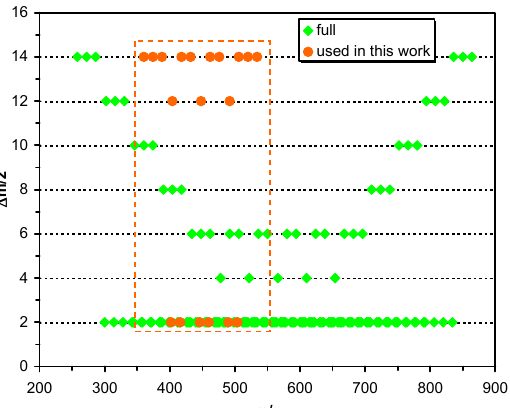
Figure 1. The variation of the m / z di ff erences in the series composed of di ff erent numbers of ethylene oxide (EO) and CH 2 units as a function of their m / z values. “Full” indicates the complete set of masses of oligomers that can be produced using all of the available monodisperse mPEG and alkylisocyanates with di ff erent chain lengths, while the marked region indicates those that were used in this study.